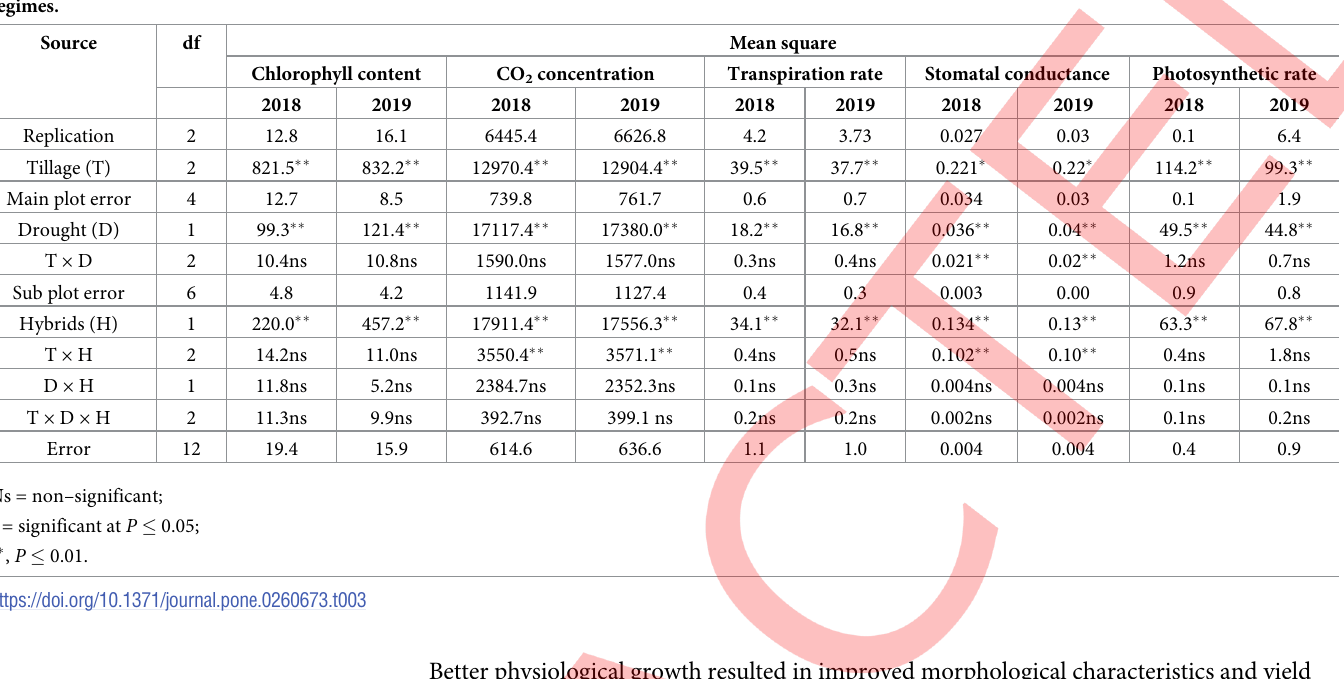
(Table 3). Our results are in line with several previous findings [18, 19] regarding sunflower growth and yield under different tillage systems. Wang et al. [18] reported that conservation tillage confers stable microbial colonies and nutrient utilization which improve soil properties and results in improved growth and productivity of sunflower. Contrary to this, Paul et al. [15] recorded higher yield with maximum soil disturbance and minimum yield with zero tillage which attributed to the hard clay soil used in that experiment, while the soil in our experiment